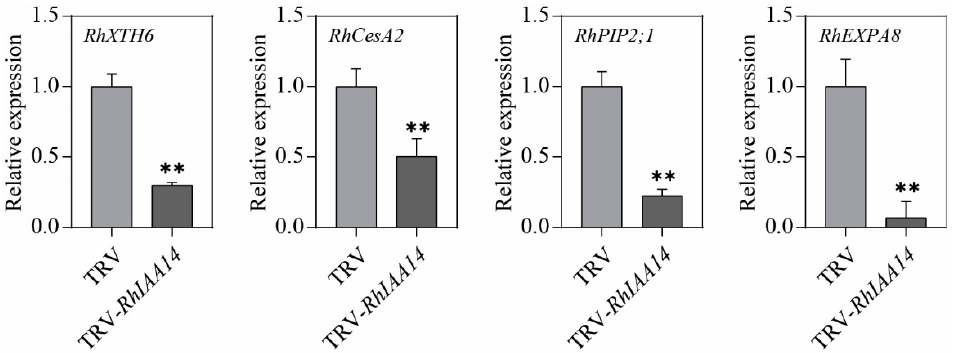
Figure 6. Transcript levels of cell-expansion-related genes in RhIAA14 -silenced and TRV control petals. Petals at stages 3–4 were used for qRT-PCR analysis. The results are the mean of three biological replicates ± SD, and the asterisks indicate significant differences, in accordance with Mann–Whitney U -test (** p < 0.01). RhUBI2 was used as an internal control.